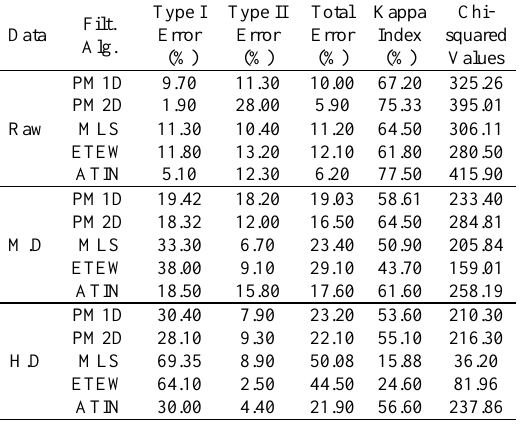
Table 5. The parameters used in the ETEW algorithm (M.D means medium-density and H.D means high-density) Quantitative evaluation results indicate that the type I, type II and total error ranges from 1.9% to 69.35%, from 2.5% to 28% and from 5.9% to 50.08%, respectively. The smallest type I error (1.9%) was committed by the PM2D algorithm when filtering raw data; whereas the smallest type 2 error (2.5%) was achieved by the ETEW algorithm when filtering the high- density data. Filtering the raw data with the PM2D algorithm resulted in the smallest total error (5.9%). It was also concluded that the greatest type I (69.35%), type 2 (28%) and total error (50.08%) were obtained by the MLS, PM2D and MLS algorithms when filtering the high-density data, raw data and high-density data,